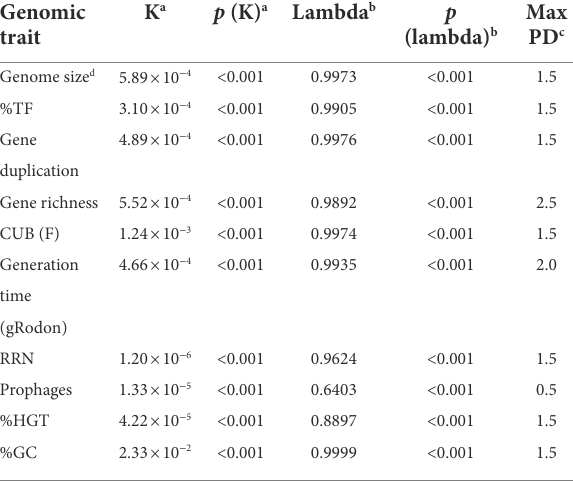
TABLE 3 Phylogenetic signals of genomic traits. Genomic